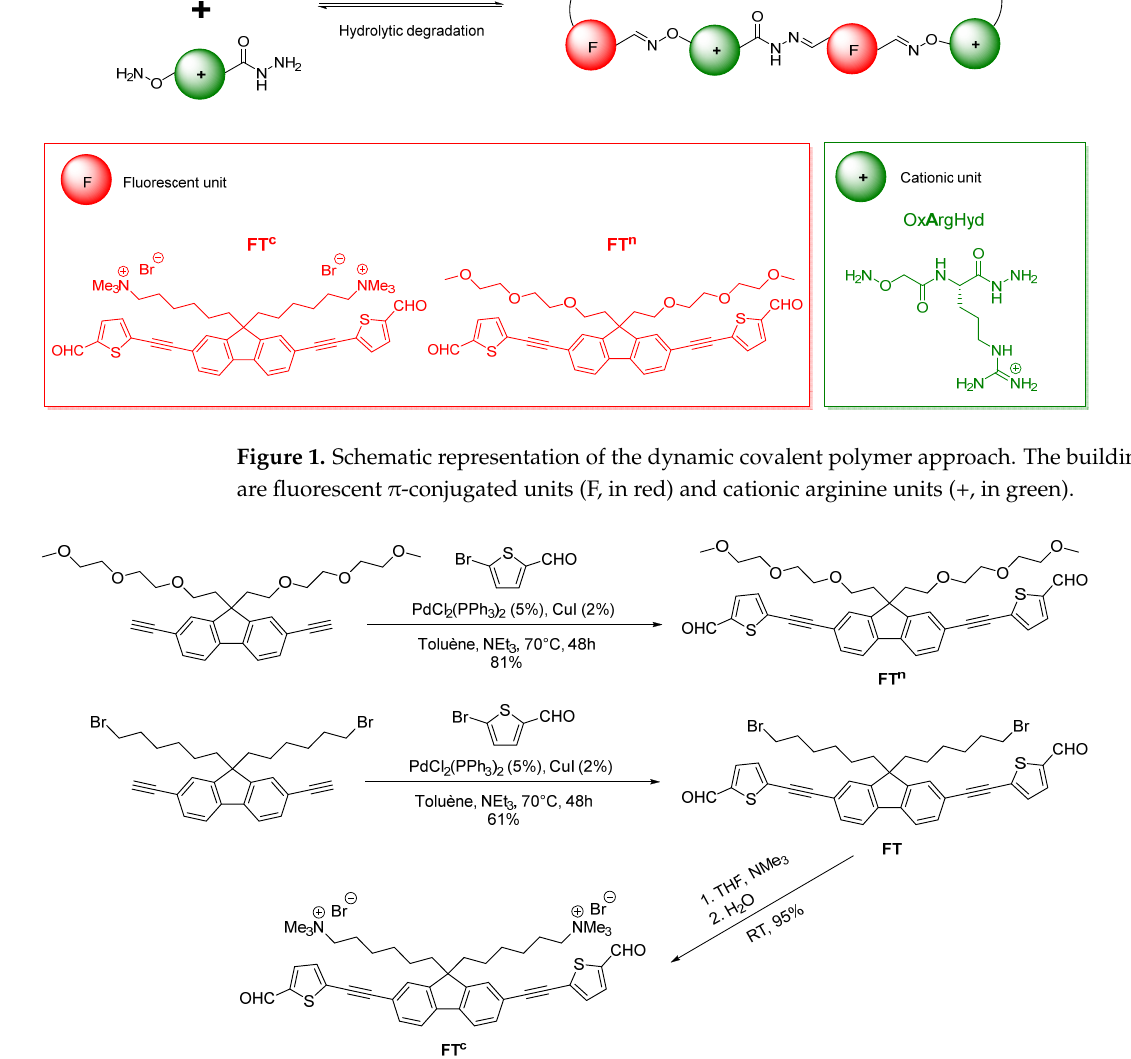
Figure 1. Schematic representation of the dynamic covalent polymer approach. The building blocks